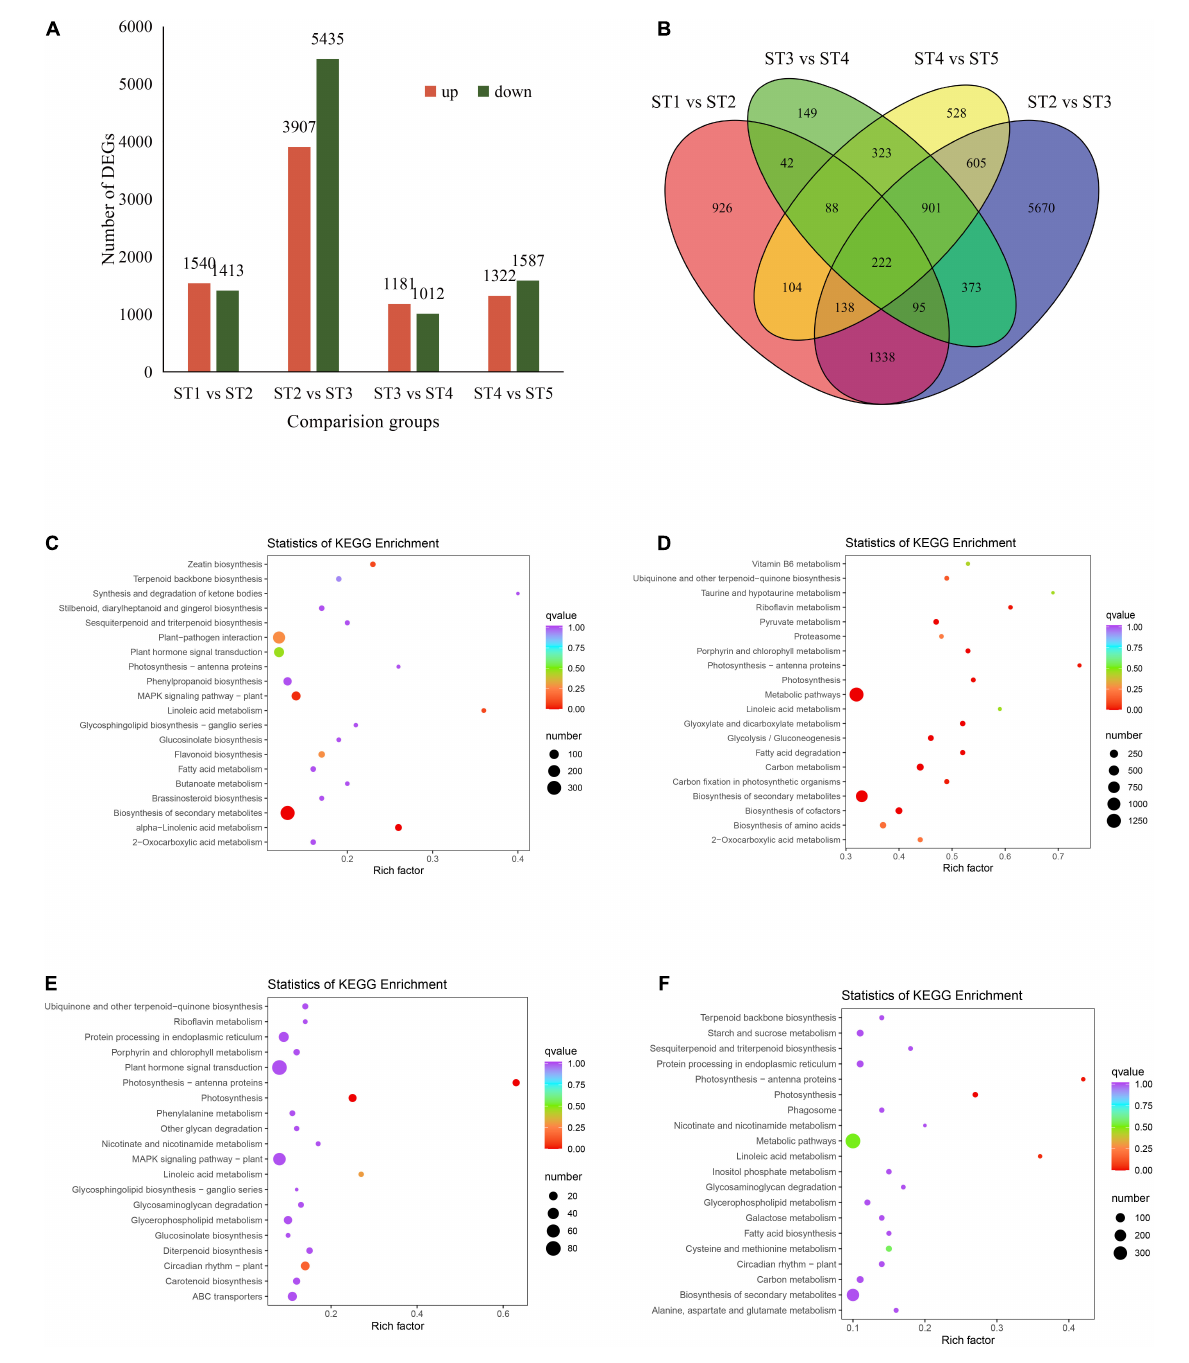
FIGURE3 DEGs involved in jujube fruit at different developmental stages. (A) Number of DEGs identified in comparison groups. (B) Venn diagram of DEGs in four comparison groups. (C–F) Represents KEGG enrichments in each pairwise comparison, respectively. The vertical coordinate represented the corresponding rich factor for each pathway, the horizontal ordinate represents the name of the pathway, the color of the dots reflects the p -value, and the redder the more significant the enrichment. The size of the dots represents the number of enriched differential